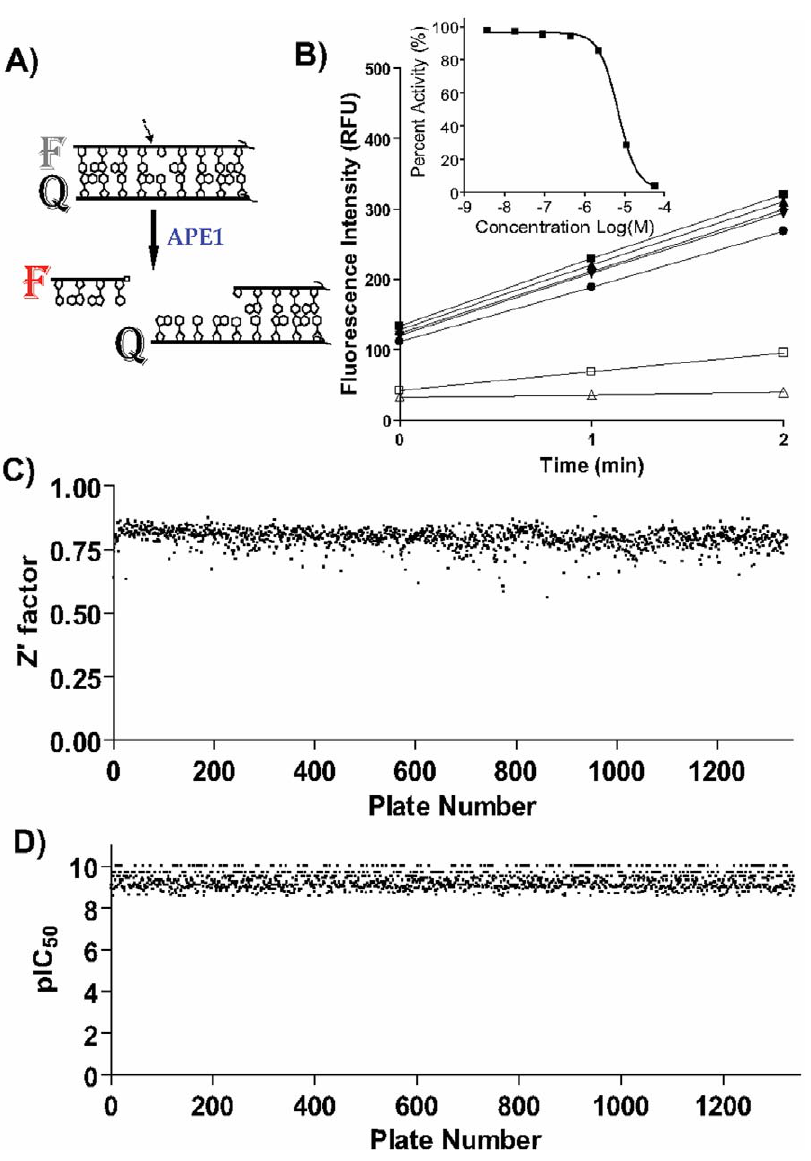
Figure 1. High-throughput screen. A) Assay principle. APE1 catalyzes and incision 5 9 relative to the abasic site analog (THF) to liberate a short 5 9 - fluorophore donor F-labeled deoxyoligonucleotide, causing increased fluorescence signal. F represents TAMRA fluorophore and Q represents Black Hole Quencher 2. The APE1 incision site is indicated by the arrow. B) High-speed data collection allows monitoring of the reaction progress in kinetic mode as shown in the main panel (3 data points collected over the course of 2 min, shown for 7 wells representing the serial dilution of